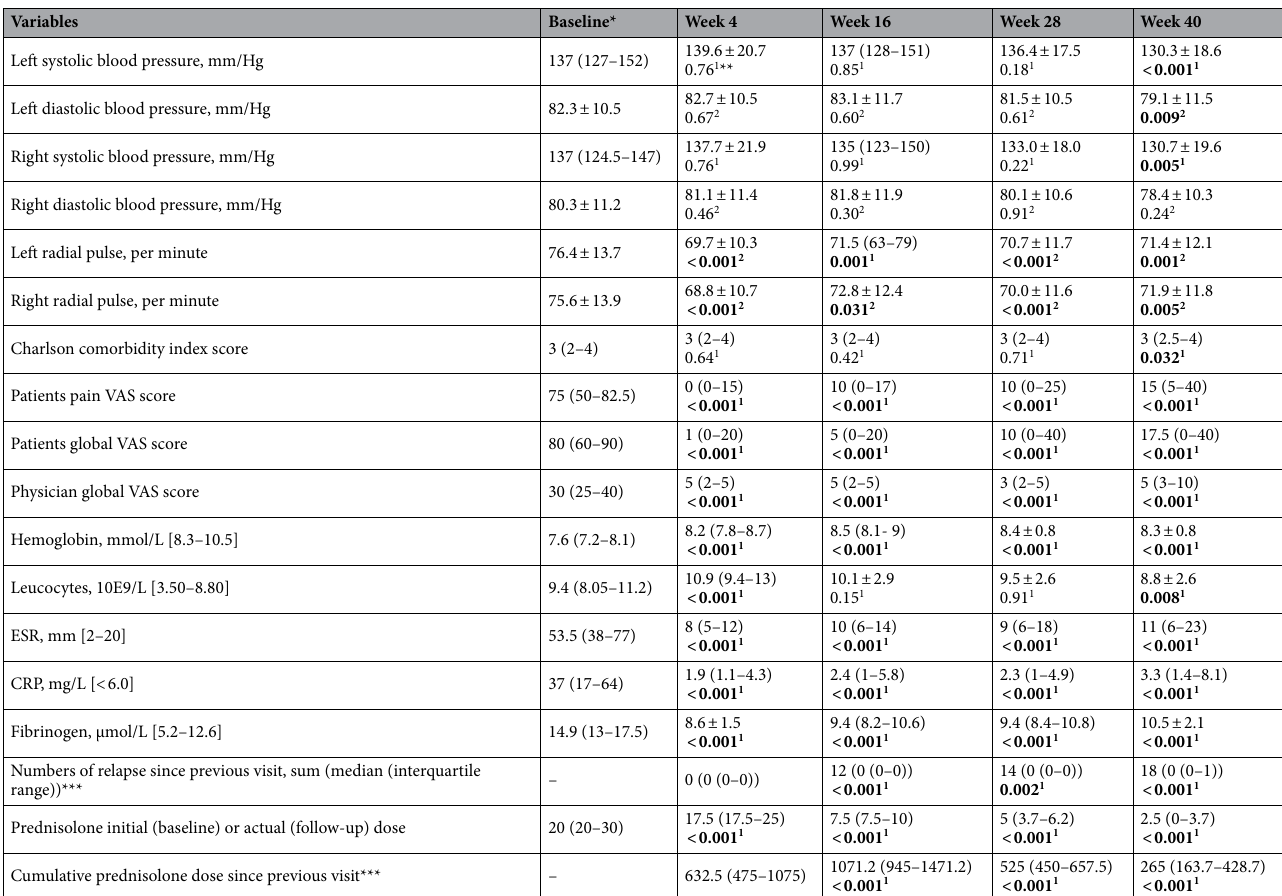
Table 1. Clinical data at baseline, week 4, week 16, week 28, and week 40. VAS visual analogue scale, ESR erythrocyte sedimentation rate, CRP C-reactive protein. p values marked in bold represent significant results. *Baseline data are gathered prior to initiation of glucocorticoids. **p values are calculated by comparison of baseline data with week 4, 16, 28 and 40. ***p values are calculated by comparison of week 4 with week 16, 28 and 40. 1 Wilcoxon signed-rank test. 2 Paired Student’s